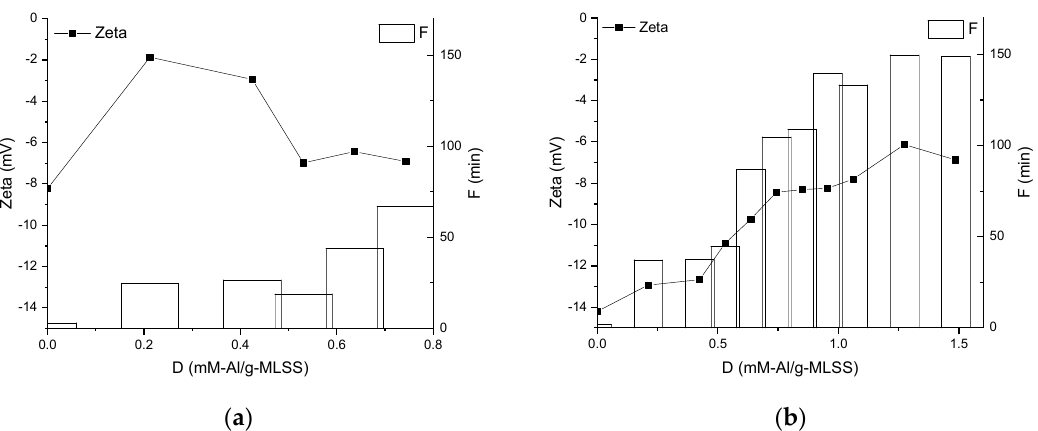
Figure 5. Influence of chemical enhancer dose on supernatant electrokinetic potential (zeta) and filtration duration of Mixed Liquors from MBBR ( a ) and IFAS ( b ).